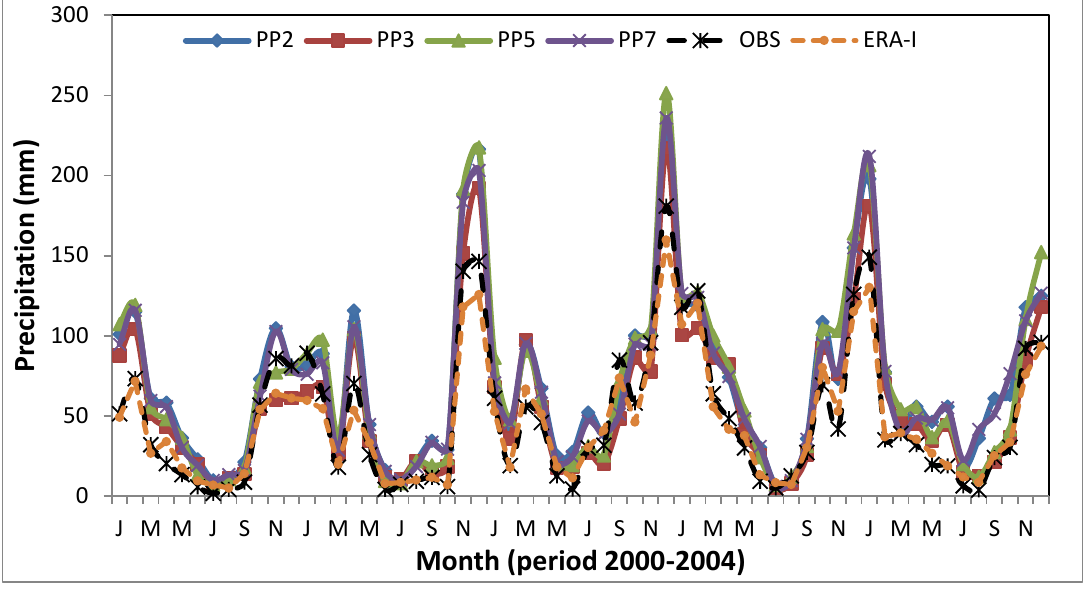
Figure 2. Observed and simulated mean monthly cumulative precipitation values on the total grid stations’ points, for the four different simulations (PP2, PP3, PP5, PP7), for the high resolution domain of Greece during 2000–2004. Table 4. Precipitation Statistical metrics of the four simulations for all stations daily precipitation (RR) for 2000–2004, over the area of Greece.